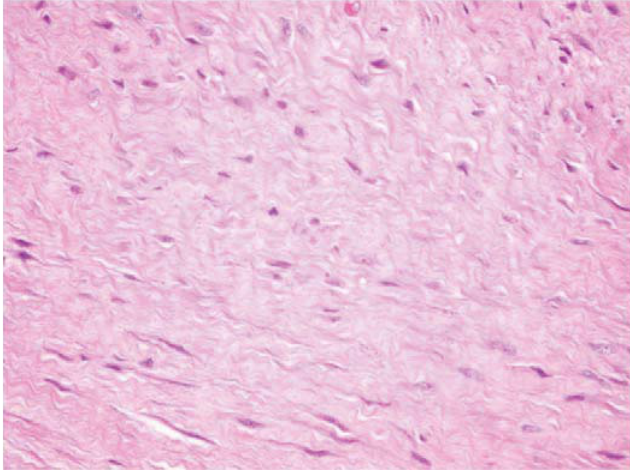
Figure 1. Histological appearance of